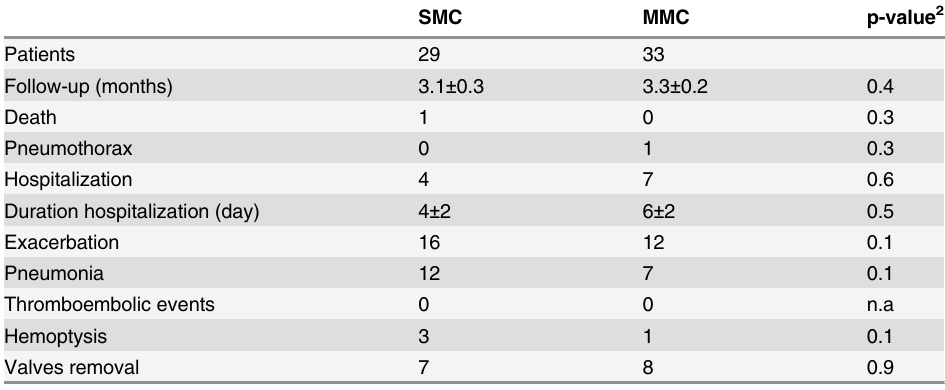
Table 3. Complications between discharge after ELVR and three-months follow-up 1